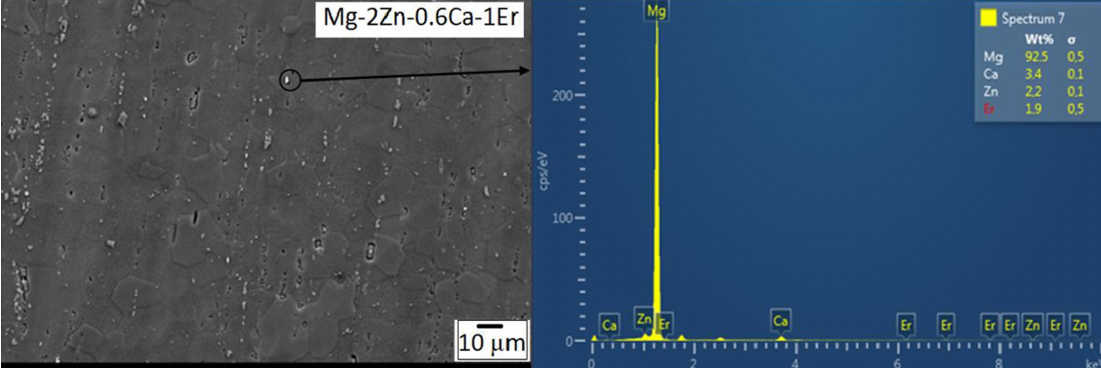
Figure 4. SEM image and EDS-analysis of as-extruded Mg-2Zn-0.6Ca-1Er .